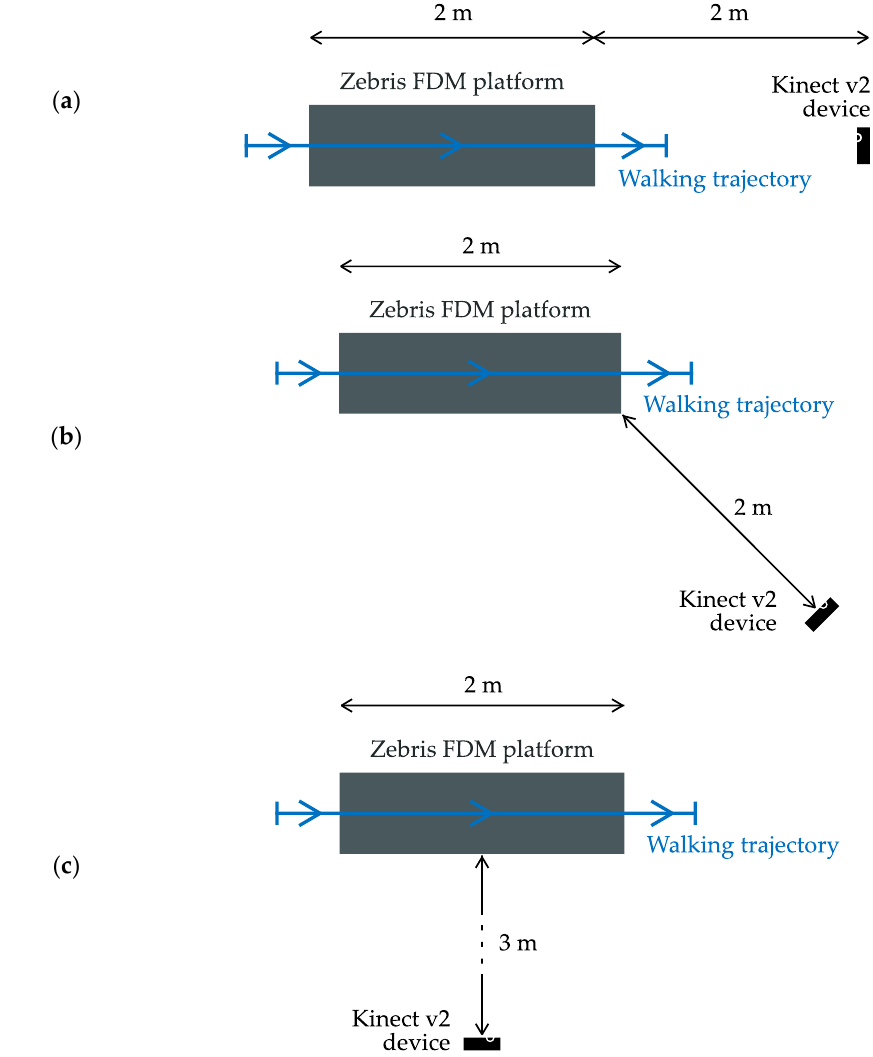
Figure 7. Configurations of the devices used in the experiments in which the angle ϕ between the depth sensor’s line of sight and the walking trajectory is approximately ( a ) 180°, ( b ) 135° and ( c ) 90°.